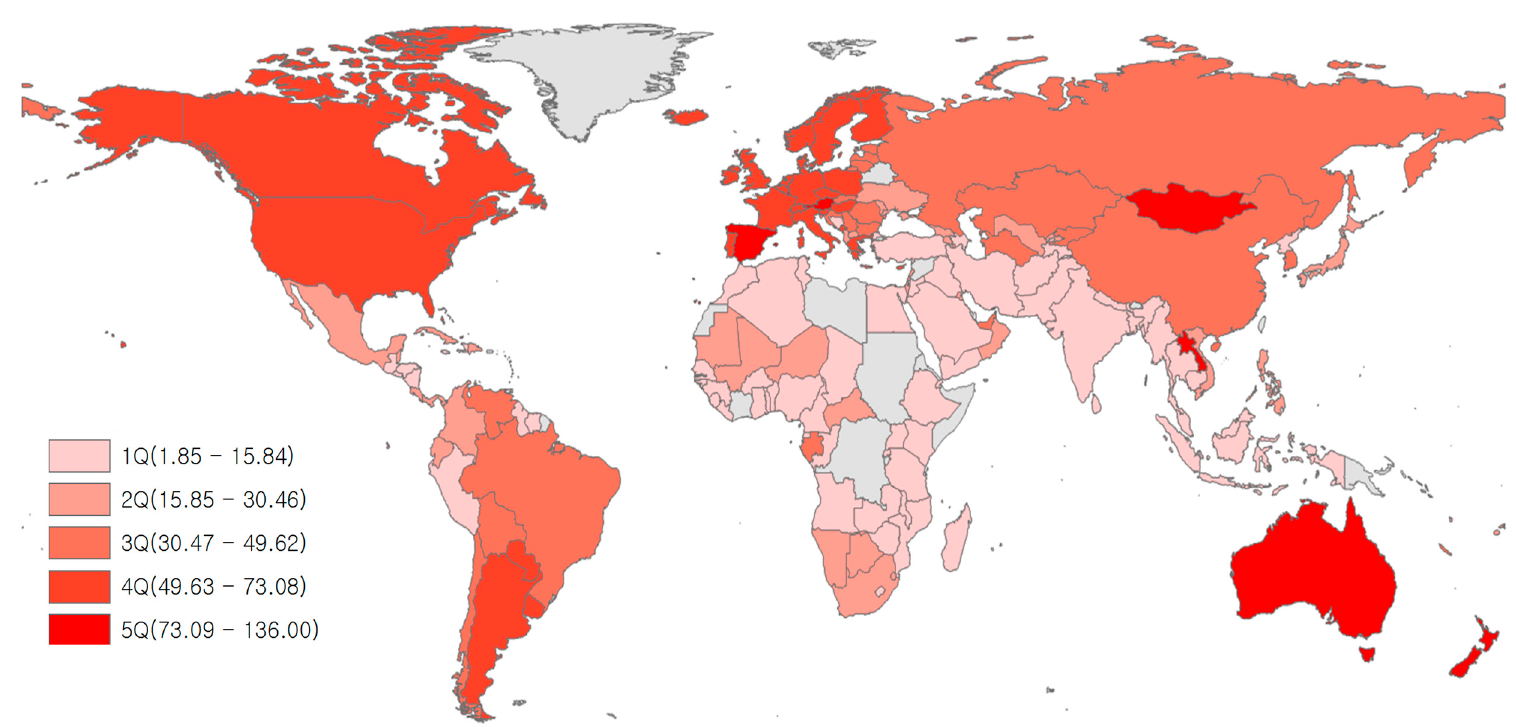
Figure 3. Mean red meat consumption (kg/capita/year) for 164 countries over the period 1992–2013. *Grey areas have no data.